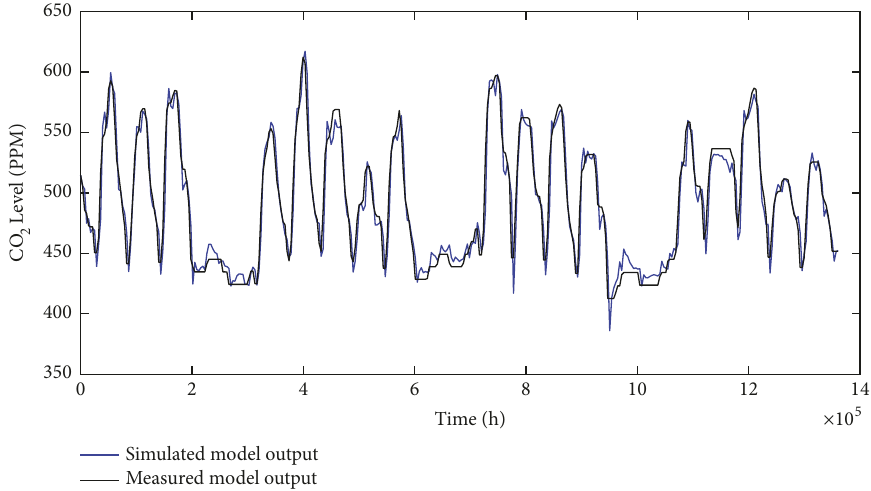
Figure 24: Validation of real measurements and outputs of CO2 level model fit